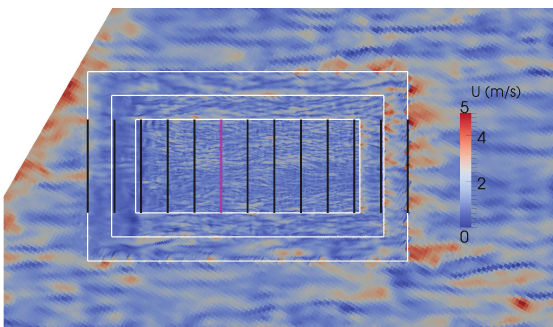
Figure 2. A horizontal plane through the free-stream wind velocity field near the ground ( z = 20 m).